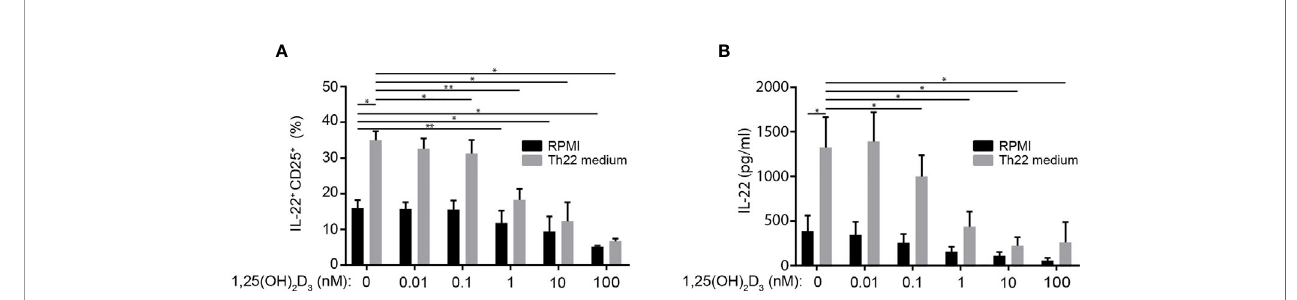
FIGURE 6 | 1,25(OH) 2 D 3 inhibits IL-22 production in the CTCL cell line Myla 2059. (A) Frequency of IL-22 + Myla 2059 cell and (B) IL-22 in the supernatant of Myla 2059 cells incubation for 48 h in the absence (black columns) or presence of Th22 medium (white columns) and in the presence of the indicated concentrations of